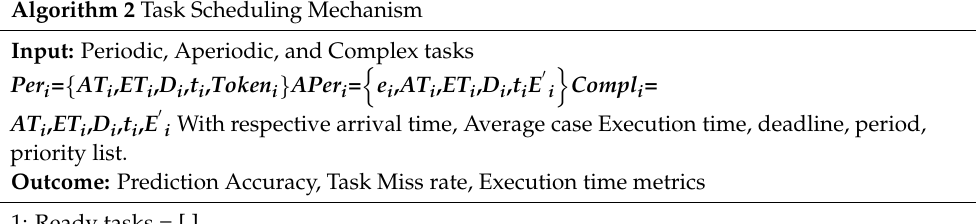
Algorithm 2 Task Scheduling